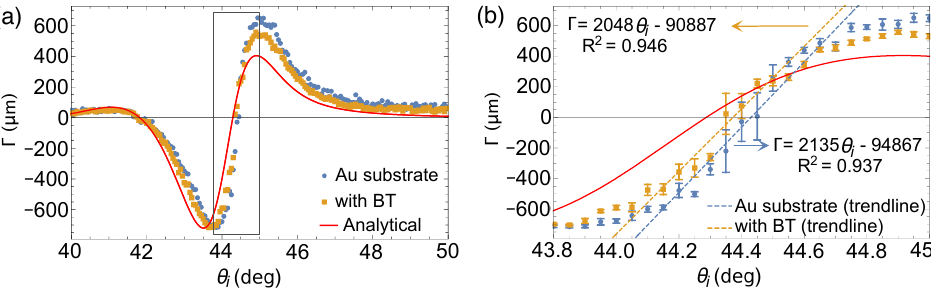
Figure 9. ( a ) GH shift of bare Au substrate and Au substrate coated with BT-SAM in comparison with analytical calculation. ( b ) GH shift within the vicinity of θ SPR (area enclosed by box in ( a )). The linear trendlines in ( b ) were used to extract θ SPR from GH shift